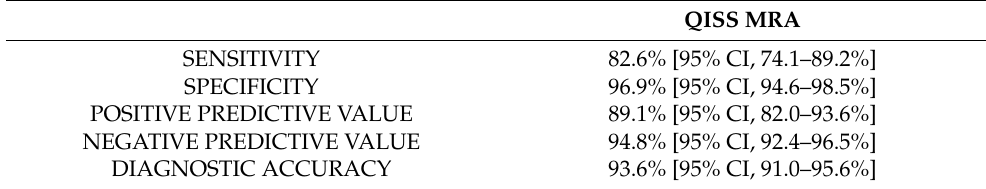
Table 4. Diagnostic accuracy parameters of quiescent-interval single-shot magnetic resonance an- giography (QISS MRA) for the detection of obstructive luminal stenosis (>70%), as compared to carbon-dioxide digital subtraction angiography (CI: confidence